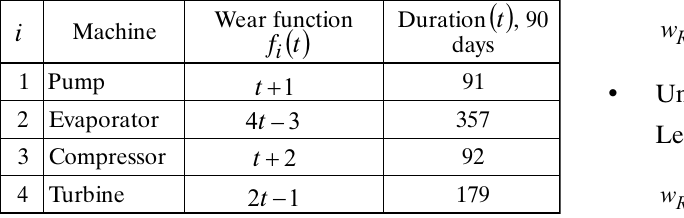
Table 2. Machine wear